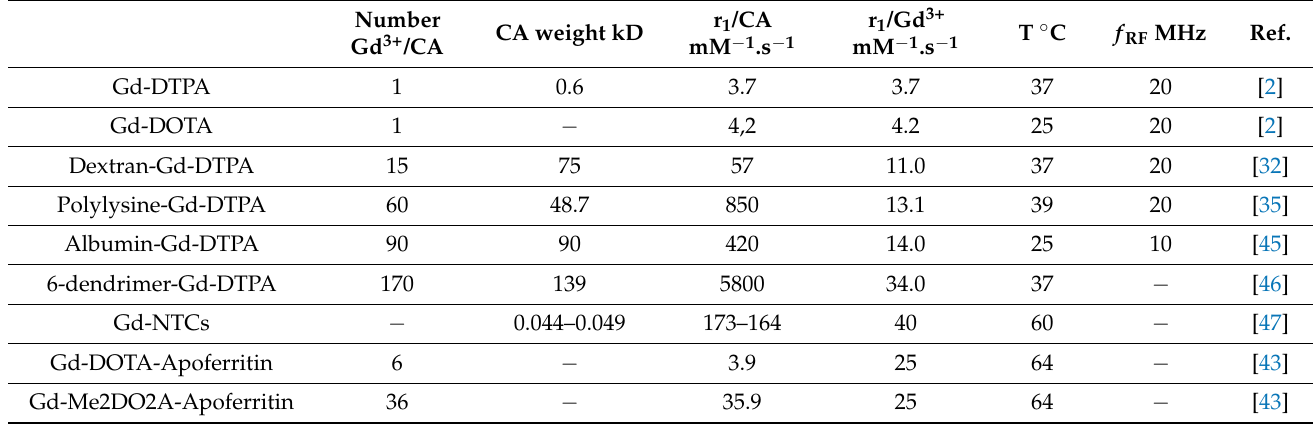
Table 1. Longitudinal relaxivities r 1 of different Gd-based CAs